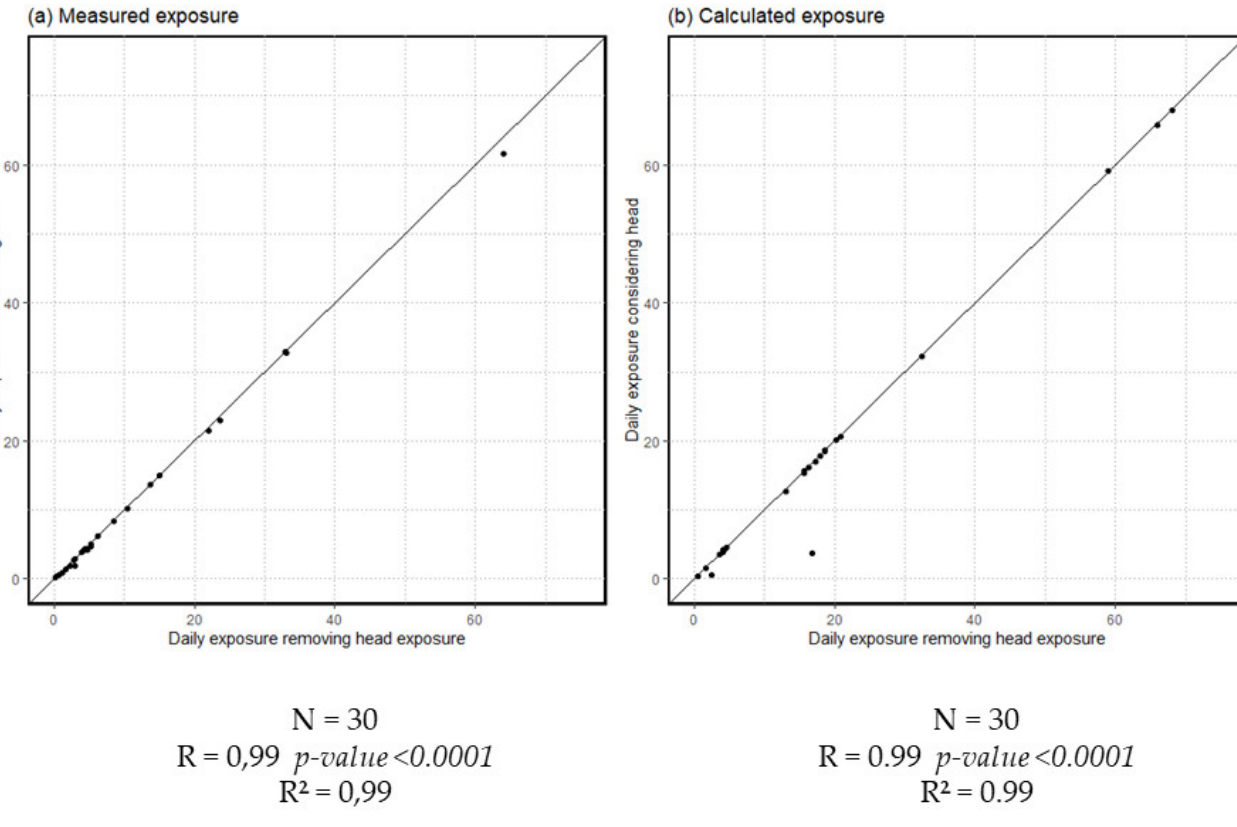
Figure A5. Linear regression of daily exposure considering head and removing head.